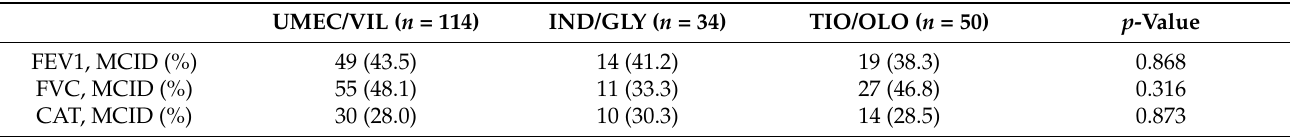
Table 2. The MCID of FEV1, FVC, and CAT after these three medicines